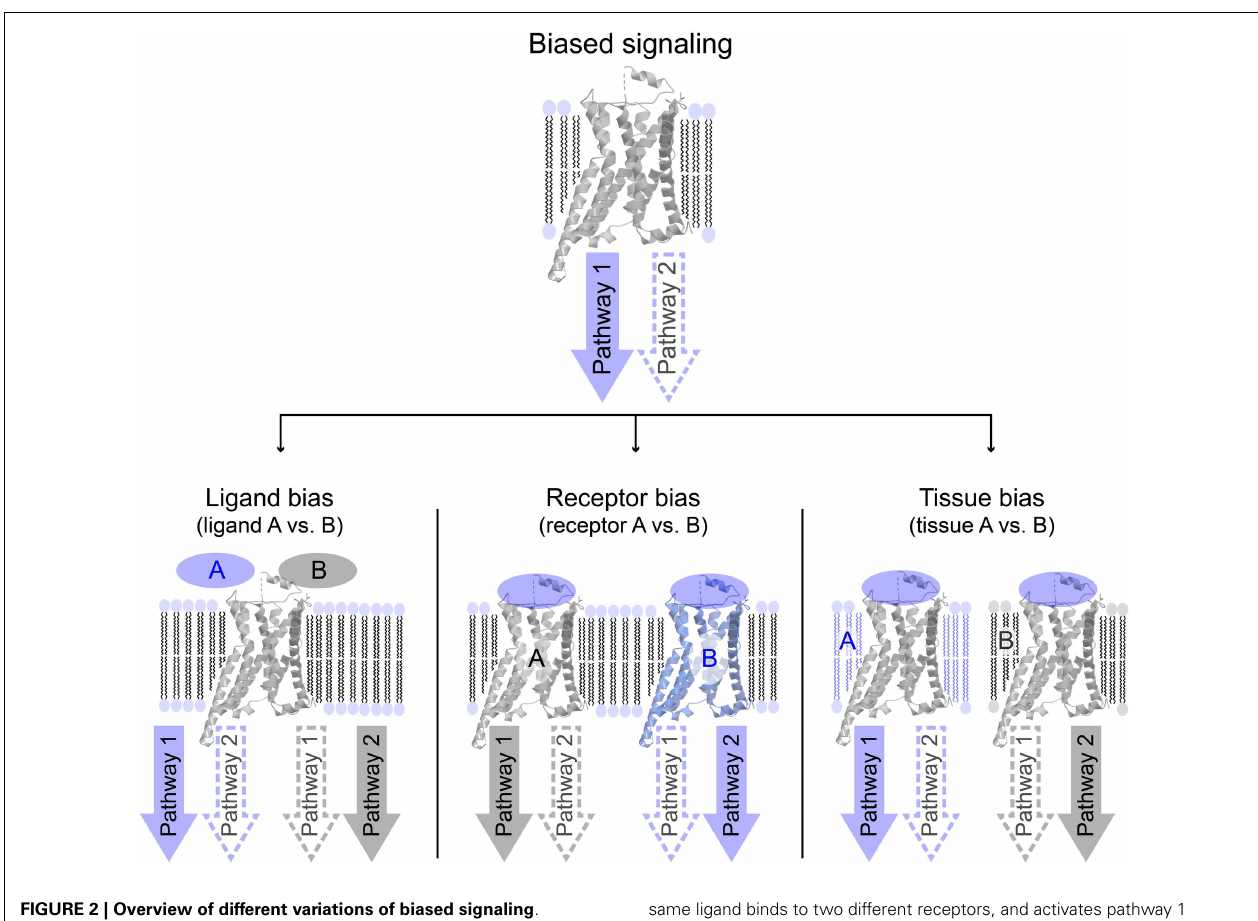
FIGURE 2 | Overview of different variations of biased signaling . Biased signaling describes a situation in which a receptor preferentially activates one signaling pathway over another. (Left) Ligand bias is used to differentiate between two ligands acting on the same receptor, where ligand A favorably activates pathway 1, whereas ligand B activates pathway 2. (Center) In receptor bias, the